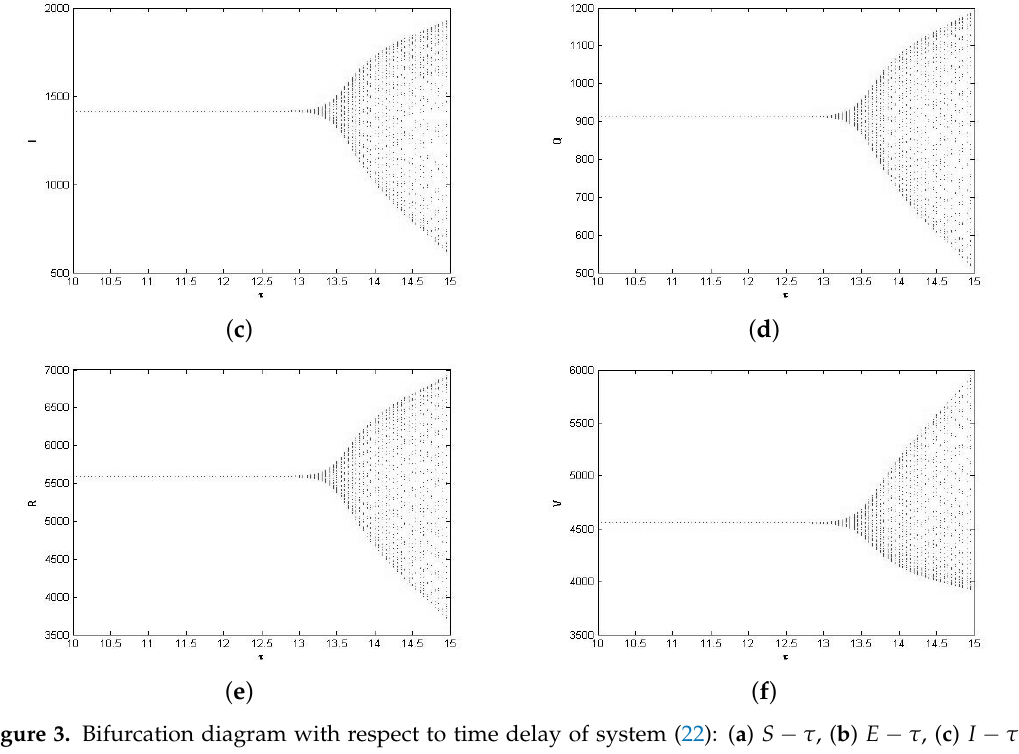
Figure 3. Bifurcation diagram with respect to time delay of system (22): ( a ) S − τ , ( b ) E − τ , ( c ) I − τ , ( d ) Q − τ , ( e ) R − τ , ( f ) V − τ .